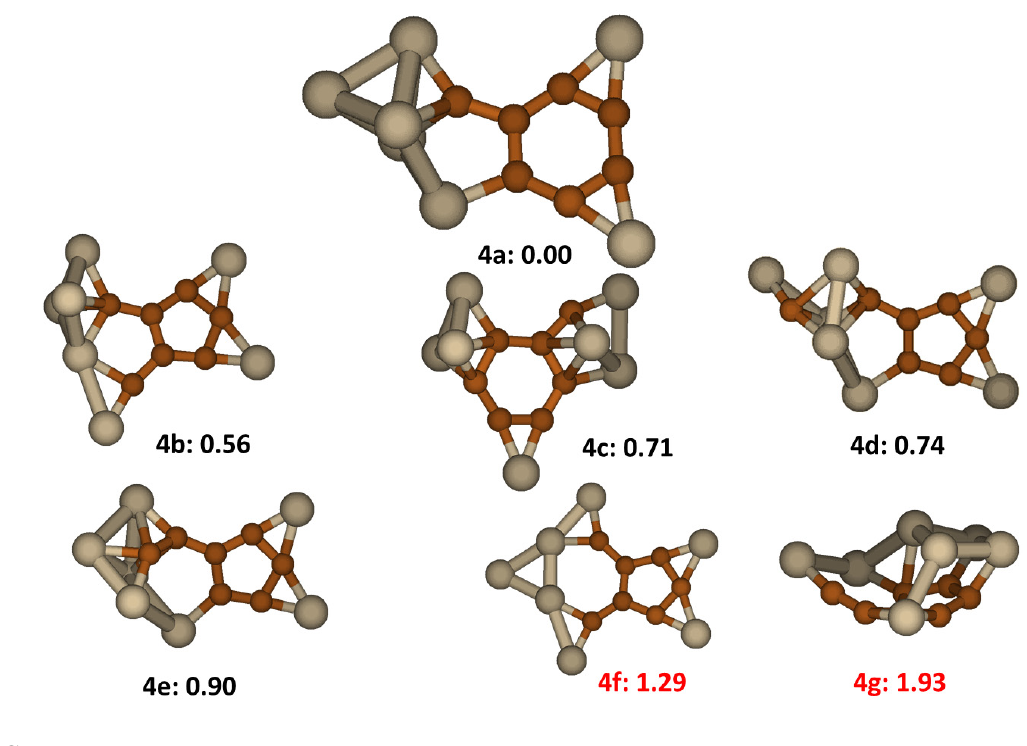
Figure 4. The structures and relative energies (in eV) of the lower energy Si Structure 4f is previously reported in ref. [20] and structure 4g is previously reported in ref.